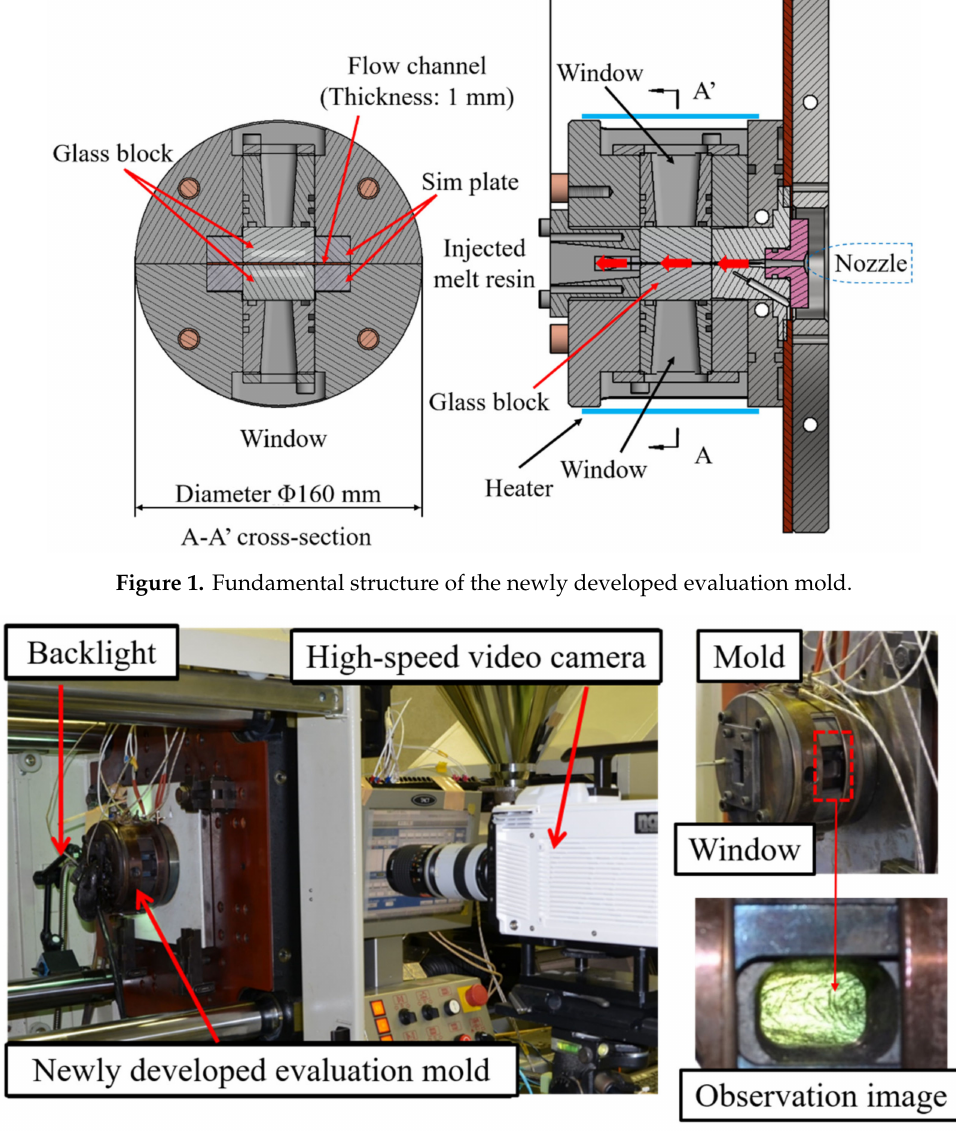
Figure 2. Evaluation mold mounted on the stationary side of